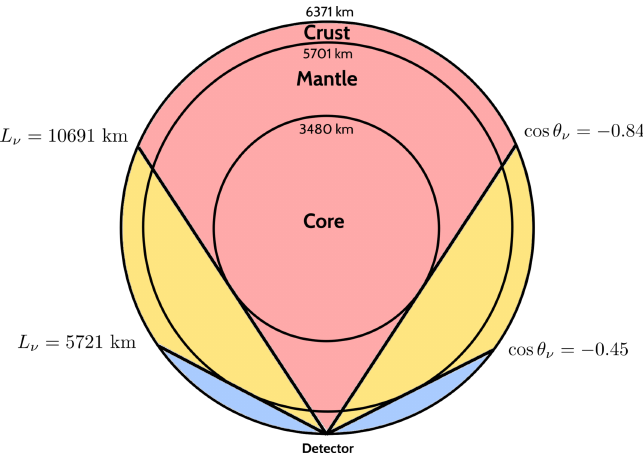
Figure 4 . Neutrinos passing through regions consisting of a particular set of layers of Earth depending upon the zenith